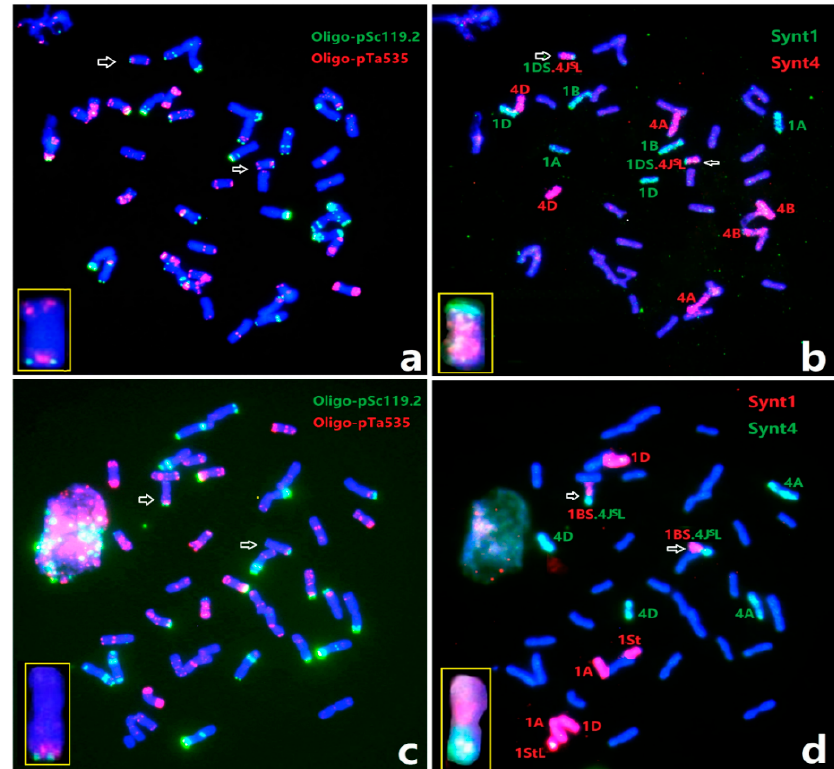
Figure 3. Sequential ND-FISH patterns showing wheat- Th. intermedium homozygous 1St transloca- tion lines . ( a,b ): 1BS.1StL and ( c , d ): 1BL.1StS. The probes for FISH were: ( a ) Oligo-B11 (green) with Oligo-pDb12H (red); ( b ) Oligo-pSc119.2 (green) with Oligo-pTa535 (red); ( c ) Oligo-k288 (red) with Oligo-D (green); and ( d ) Oligo-pSc119.2 (green) with Oligo-pTa535 (red). The arrows indicated the translocation chromosomes.